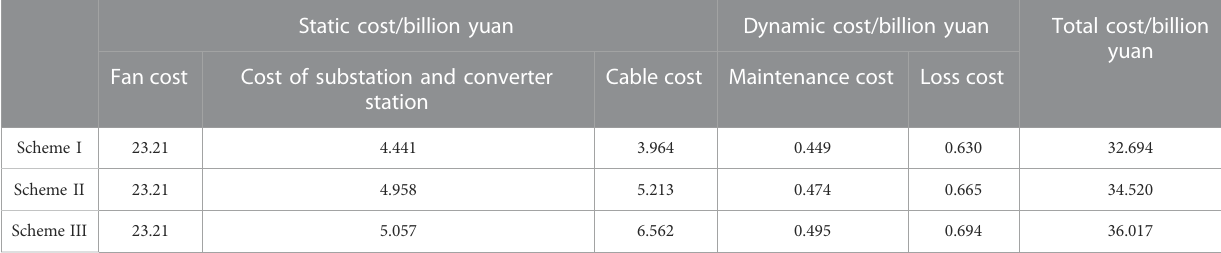
TABLE 7 Cost estimation of planning